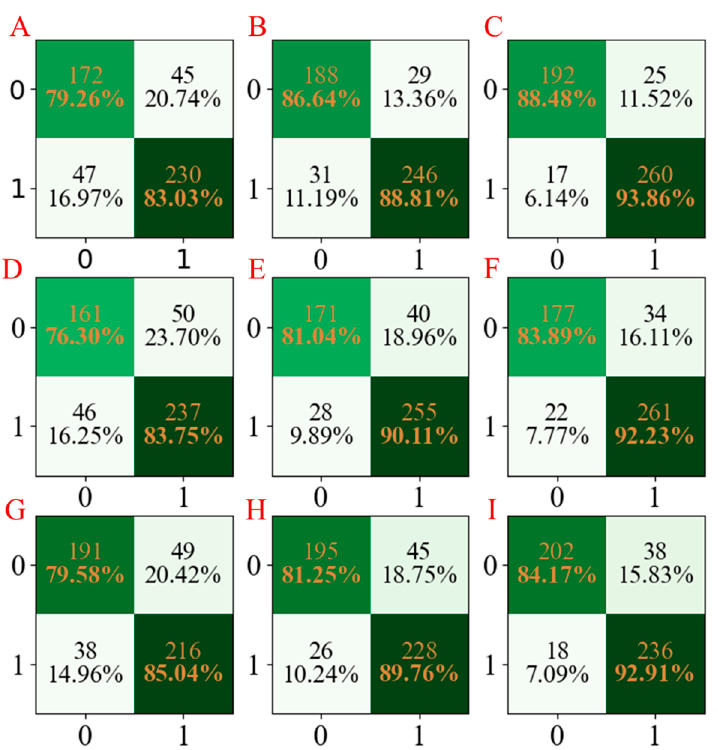
Figure 5. The confusion matrix of three models established for hERG characteristics. The confusion matrix of the PLS-DA model using seed numbers 1234 ( A ), 5678 ( D ), and 1278 ( G ); the confusion matrix of the AdaBoost model using seed numbers1234 ( B ), 5678 ( E ), and 1278 ( H ); the confusion matrix of the LGBM model using seed numbers 1234 ( C ), 5678 ( F ) and 1278 ( I ). Table 3. The precision, recall, and F1-score values of the established models for hERG properties. Methods